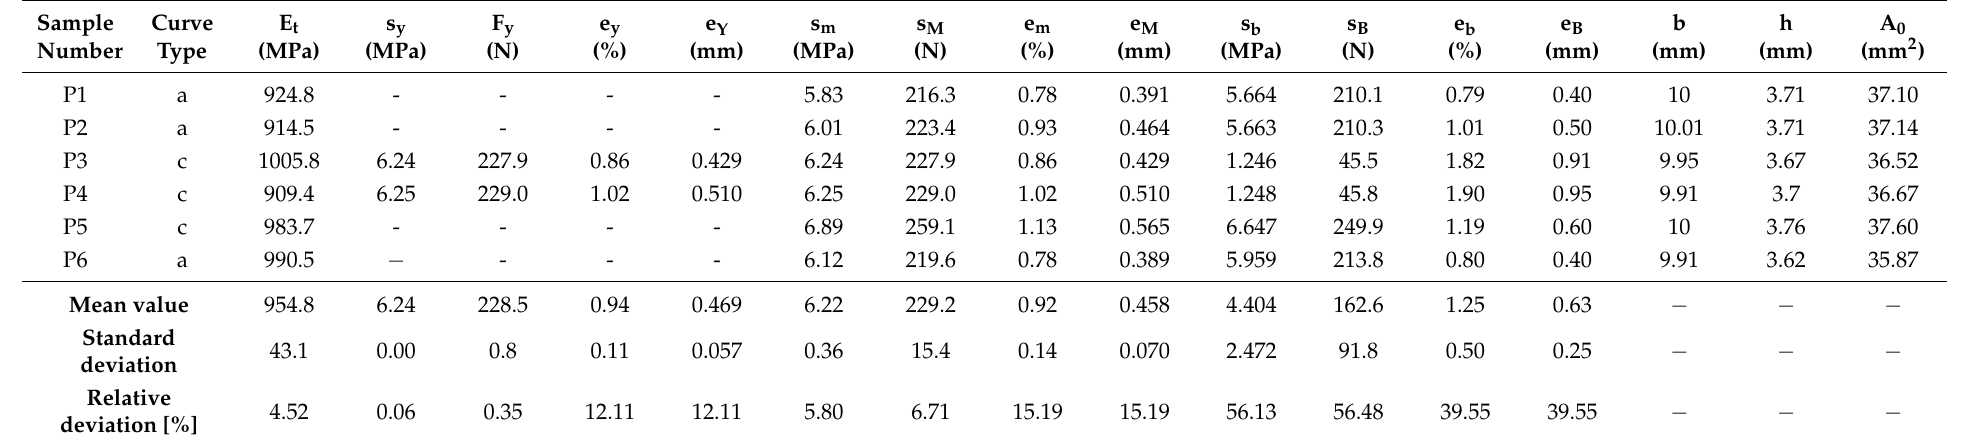
Table A44. Results of the tensile tests of P.